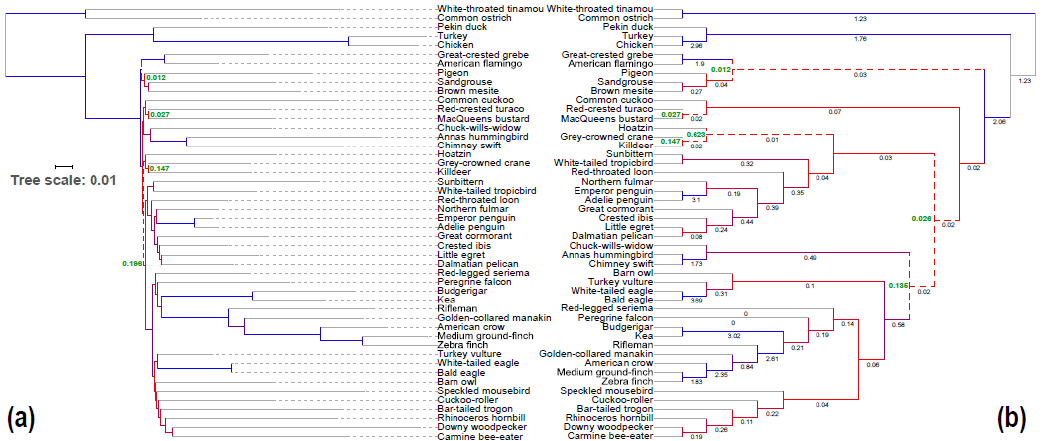
Figure 2. Evidence for extensive gene tree–species tree conflict at the base of Neoaves. ( a ) Total Evidence Nucleotide Tree (TENT) maximum likelihood (ML) tree of Jarvis et al. [15] with branch lengths in mutation units, drawn using Interactive Tree Of Life (iTOL) [23]. Branches are colored by Quartet Score (QS) computed using ASTRAL based on all 14,446 unbinned nt gene trees with branches that have bootstrap support (BS) ≤ 5% contracted. Low QS (red) in deep divergences among Neoaves are suggestive of high levels of ILS. The null hypothesis of a polytomy could not be rejected for four branches (dashed lines) at the p < 0.01 level ( p -values shown in green on nodes where the null hypothesis is rejected) [19]; ( b ) ASTRAL-III tree run on all 14,446 unbinned nt gene trees with branches with BS ≤ 5% contracted, as reported by [24,25]. Branch lengths in coalescent units computed by ASTRAL are written under each branch. Branch colors are identical to (a). The null hypothesis of a polytomy could not be rejected for six branches (dashed lines) at the p < 0.01 level ( p -values shown in green on nodes where the null hypothesis is rejected).